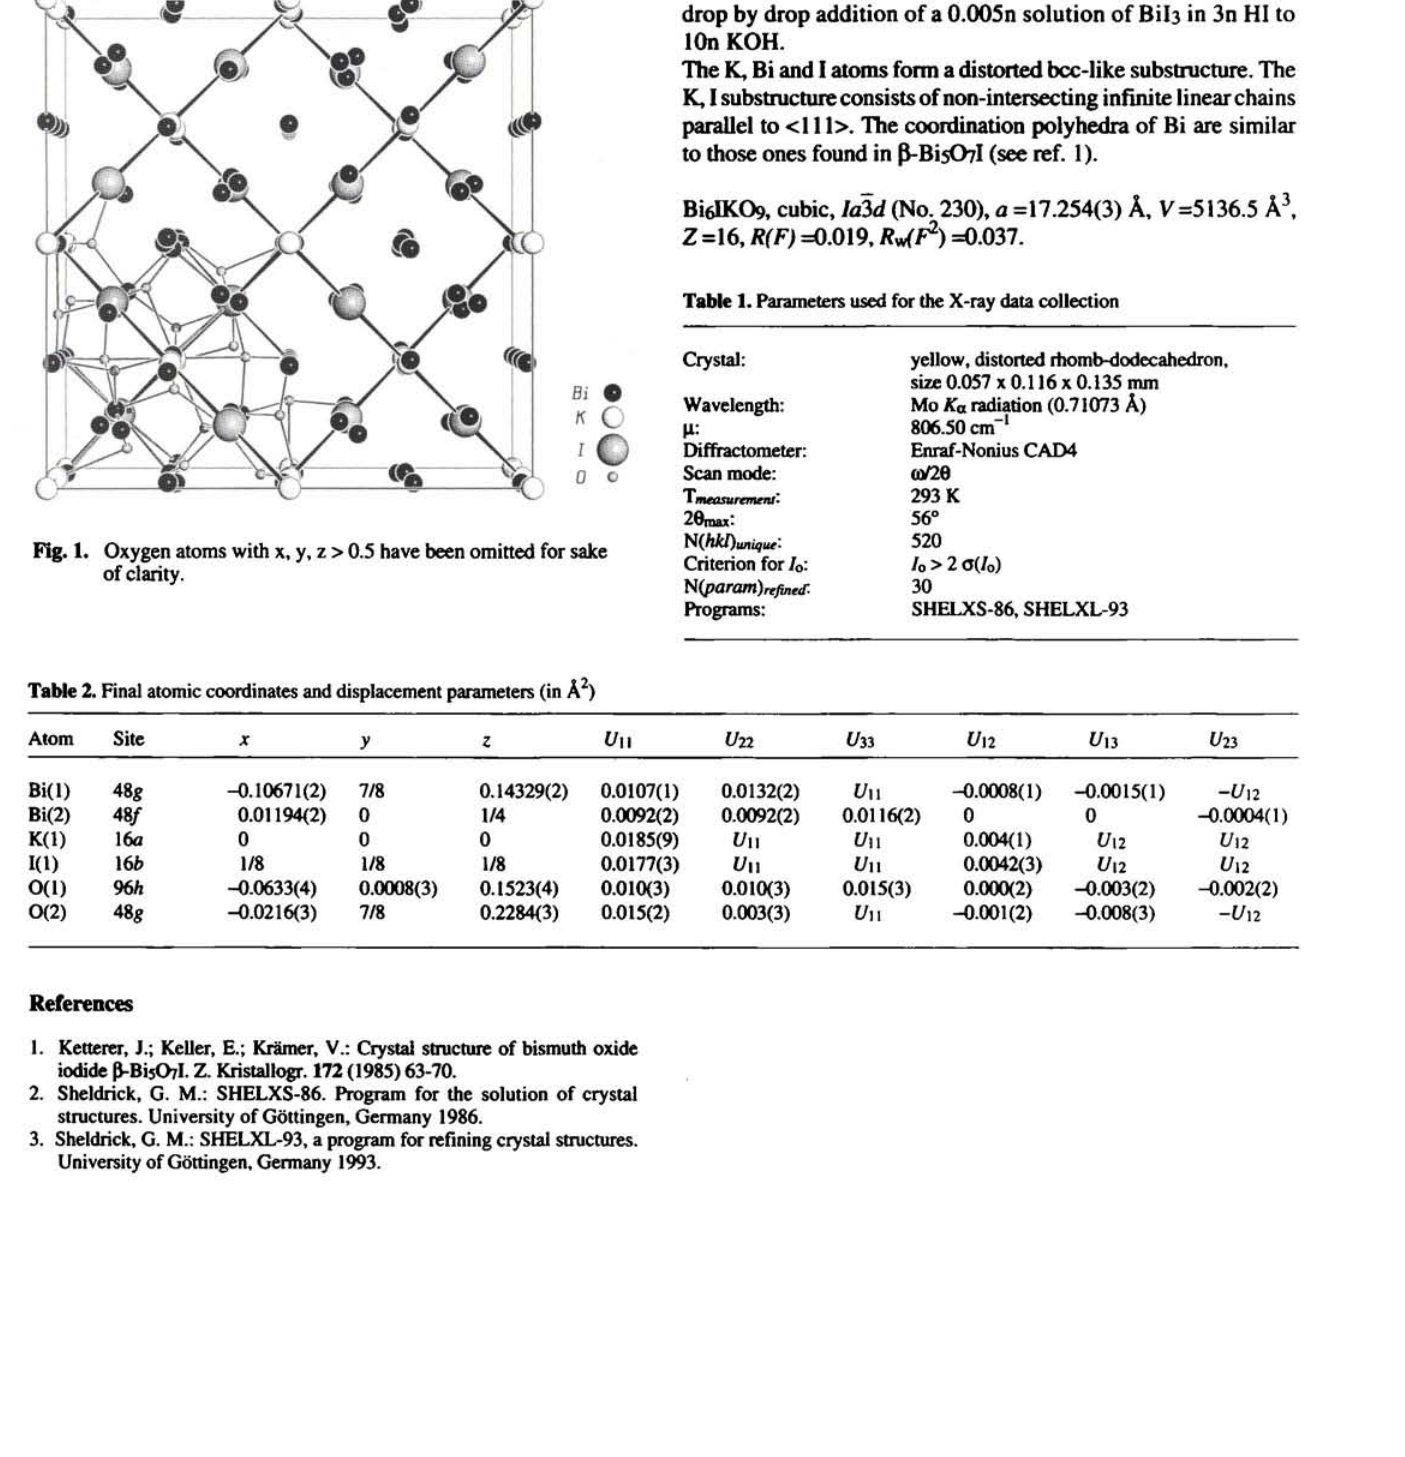
Fig. 1. Oxygen atoms with x, y, ζ > 0.5 have been omitted for sake of clarity.